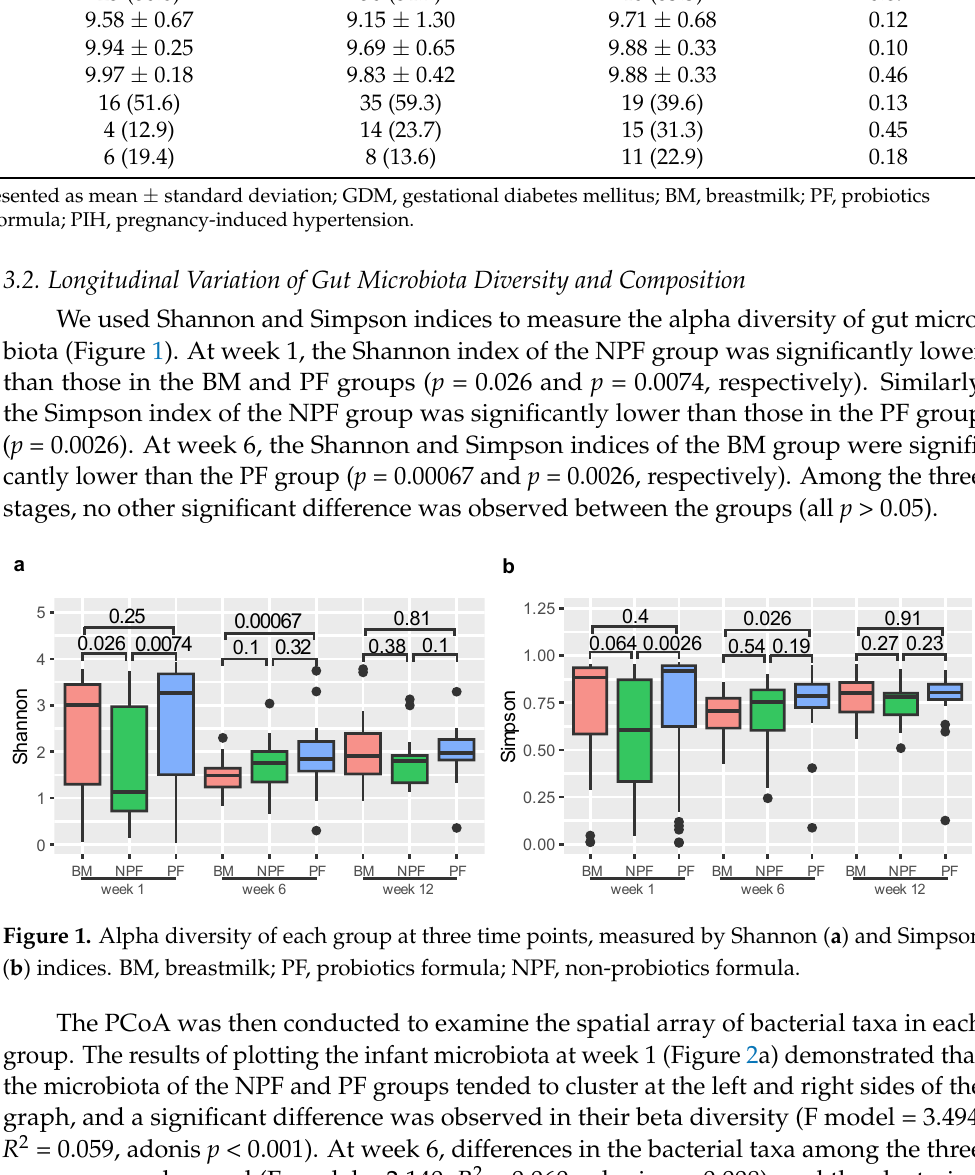
Table 1. Clinical characteristics of participants.